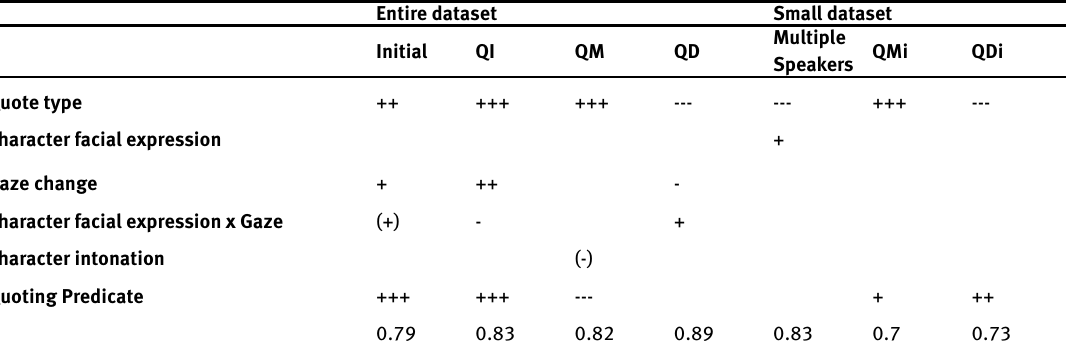
Table 13: Overview of all regression results. Significance is indicated as follows: +++/--- indicates p < 0.001, ++/-- p < 0.01, +/- p < 0.05 and (+)/(-) p < 0.1, with + or - marking positive or negative estimates. C indicates the fit of each